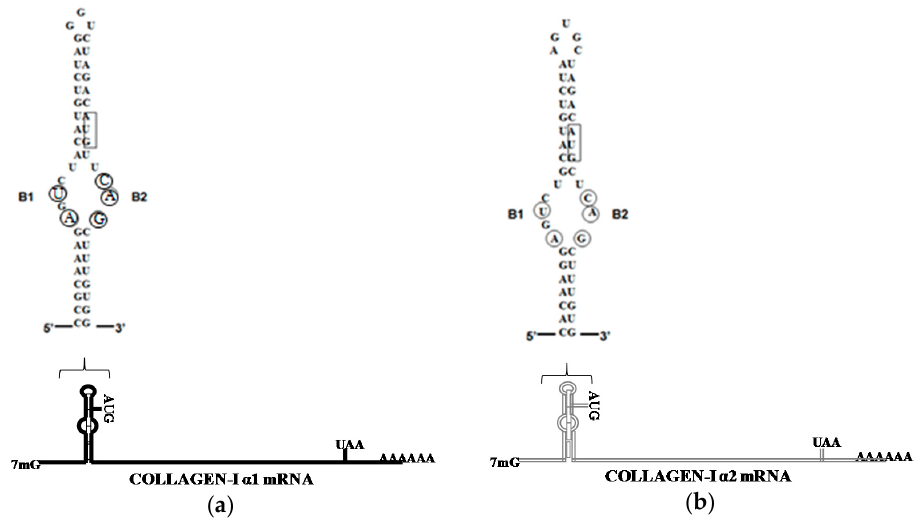
Figure 1. ( a ) Sequence of the 5 ′ SL (stem-loop) of human collagen α 1(I) mRNA; and ( b ) sequence of the 5 ′ SL of human collagen α 2(I) mRNA. Nucleotides critical for LARP6 binding are circled and translation start codon is boxed.